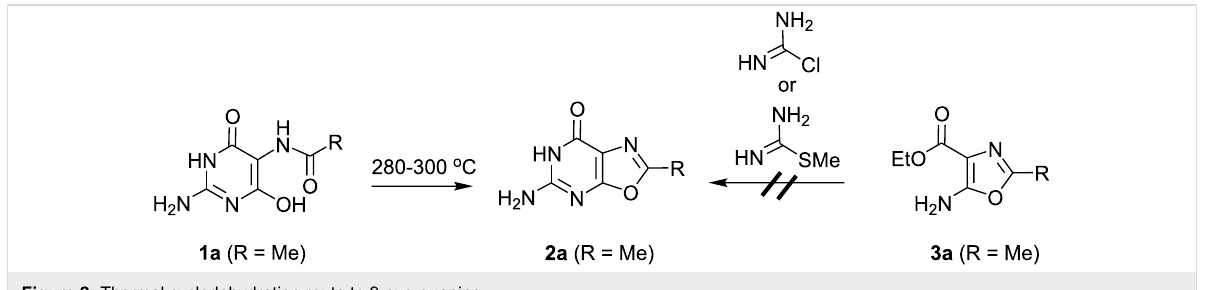
Figure 2: Thermal cyclodehydration route to 9-oxo-guanine.